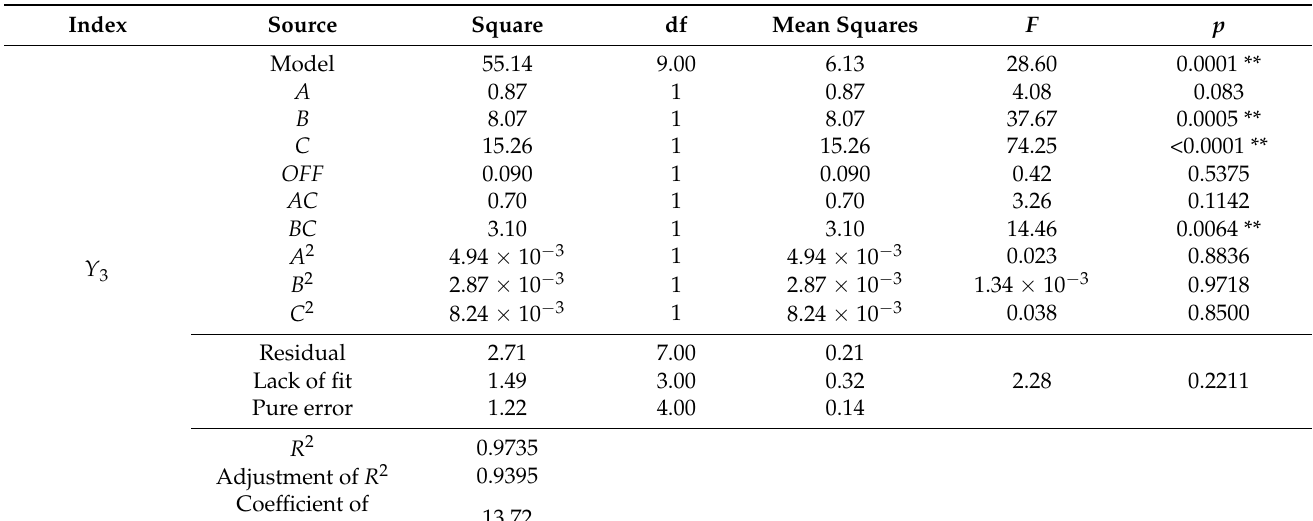
Table 5. Variance analysis of damage rate.